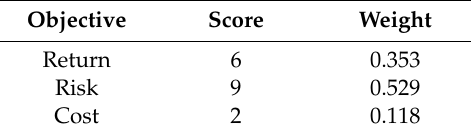
Table 4. Scores and weights of the